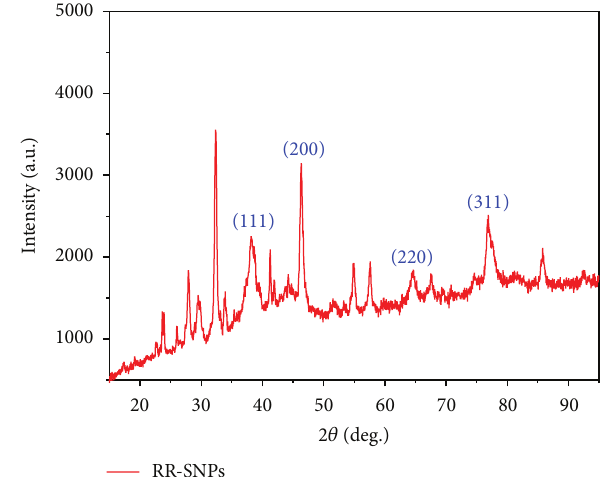
Figure 4: XRD pattern of biogenic RR-SNPs.